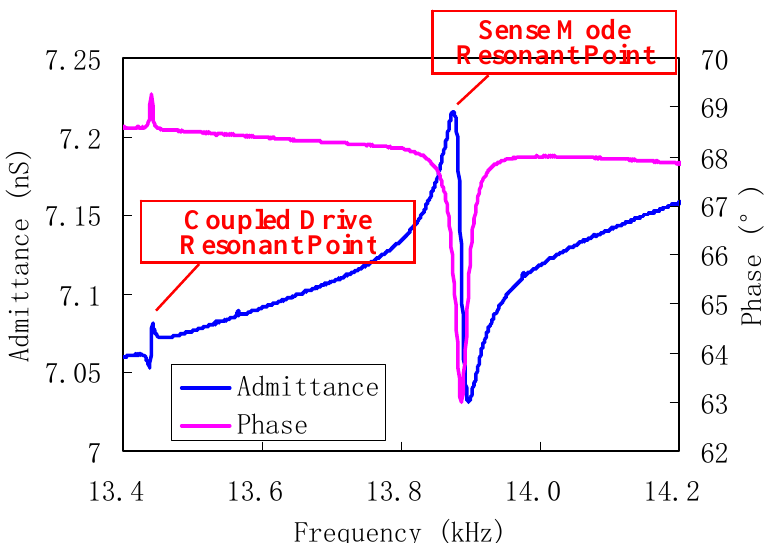
Figure 15. Admittance of sense